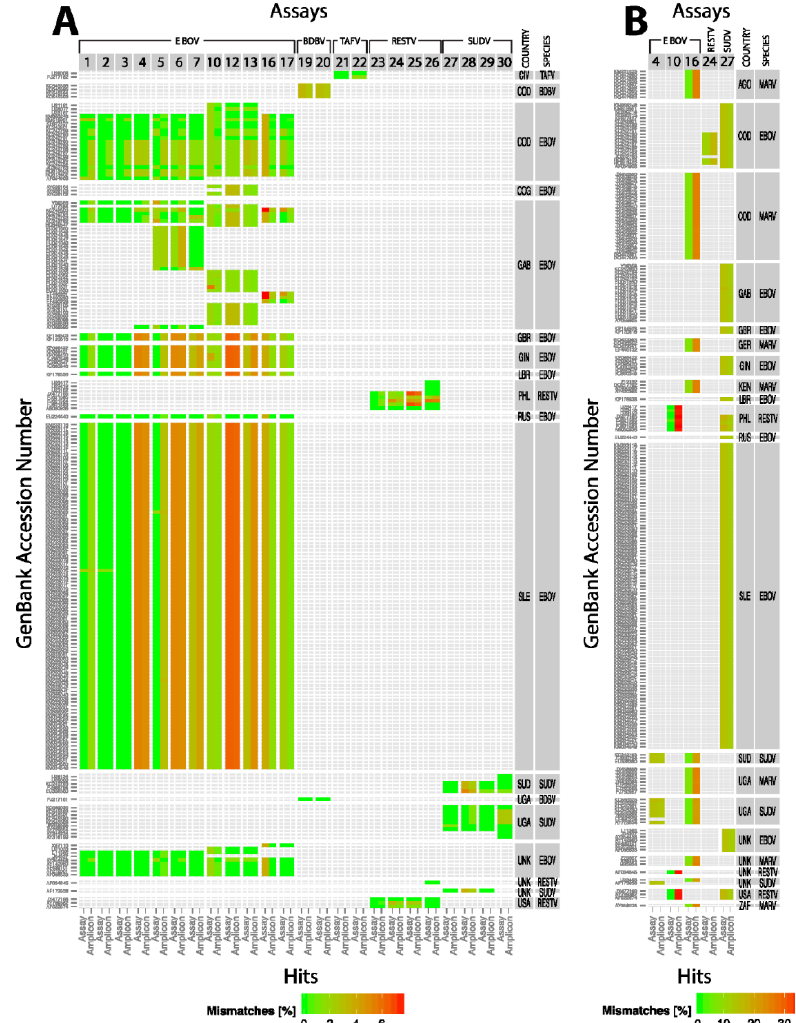
Figure 2. Heat map of assay and amplicon hits for each assay based on percentage mismatches between the reference and various GenBank sequences. The various assays, numbered in the same order as in Table S1, are grouped according to specificity of the assay; i.e. , EBOV (1–17), BDBV (19–20), TAFV (21–22), RESTV (23–26), and SUDV (27–30). The GenBank accession numbers are provided on the left, and the corresponding ebolaviruses and isolation countries are labeled on the right. The country of isolation is based on the information provided in GenBank entries. Country codes: AGO-Angola; CIV-Ivory Coast; COD-Democratic Republic of Congo; COG-Congo; GAB-Gabon; GBR-United Kingdom; States of America; ZAR-South Africa. Assays/amplicon hits that match at 100/100 rule are in green, and others with various percent mismatches are color coded according to the scale at the bottom. ( A ) represents the sensitivity (color) and specificity (species) of true-positive hits to the respective assays; ( B ) represents the sensitivity (color) and lack of specificity (cross reactivity) to the respective assays. False-positive (#10, #16), true-negatives (#4, #24, #27). Note that the heat index scale is different in panels A and B.